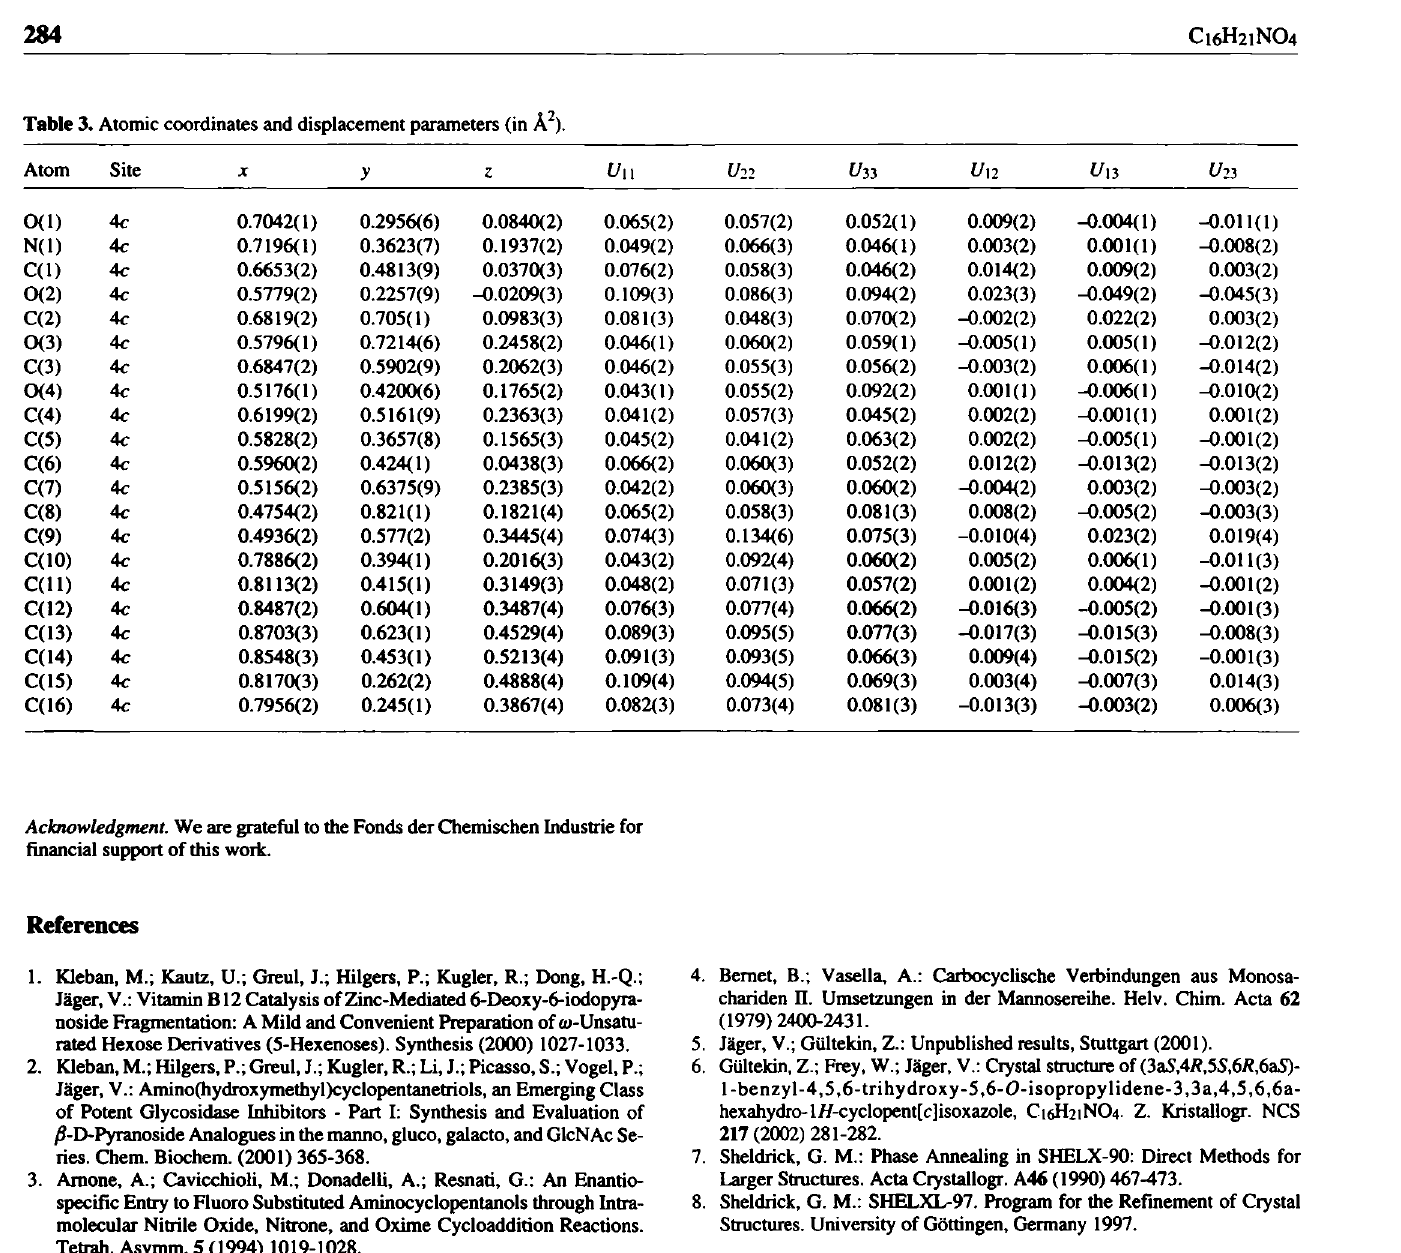
Table 3. Atomic coordinates and displacement parameters (in Â 2